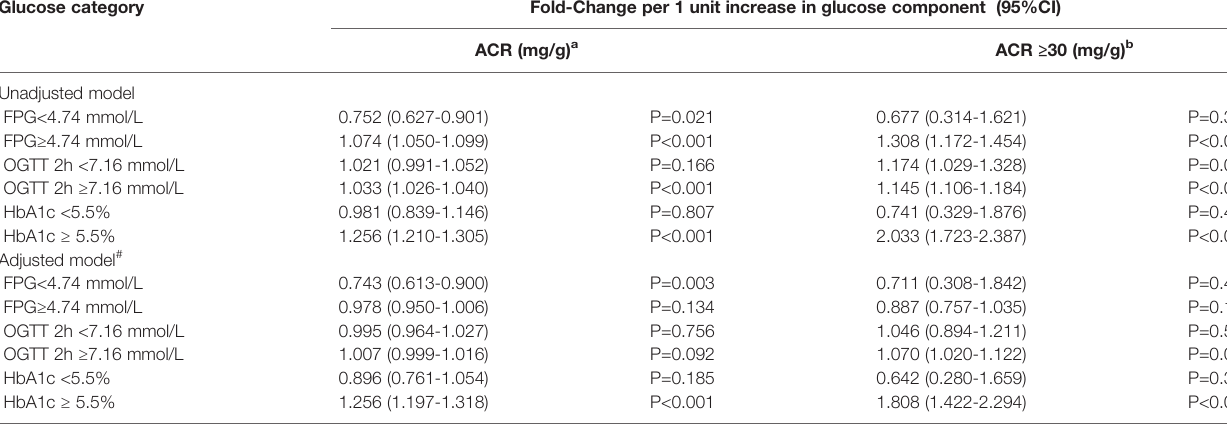
TABLE 2 | Regression models of the relationship between glucose and ACR. Glucose category Fold-Change per 1 unit increase in glucose component (95%CI)